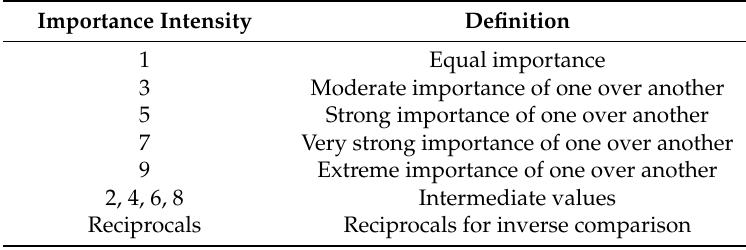
Table 1. The 1–9 scale for the pairwise comparisons in the Analytic Hierarchy Process